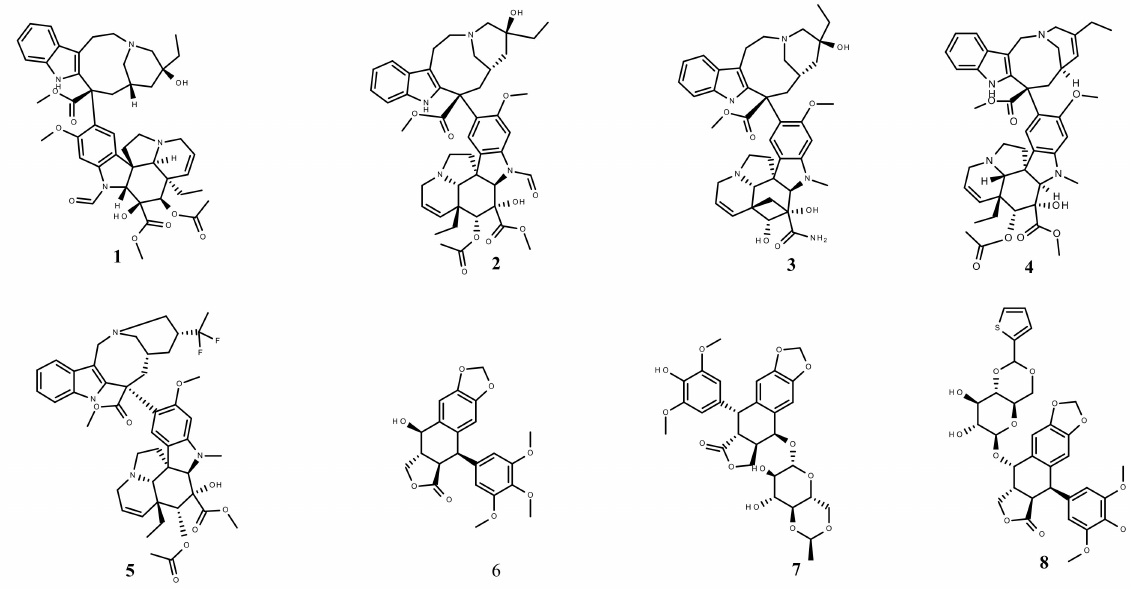
Figure 4. Chemical structures of (1) vincristine, (2) vinblastine, (3) vindesine, (4) vinorelbine, (5) vinflunine, (6) podophyllo- toxin, (7) etoposide and (8) teniposide.